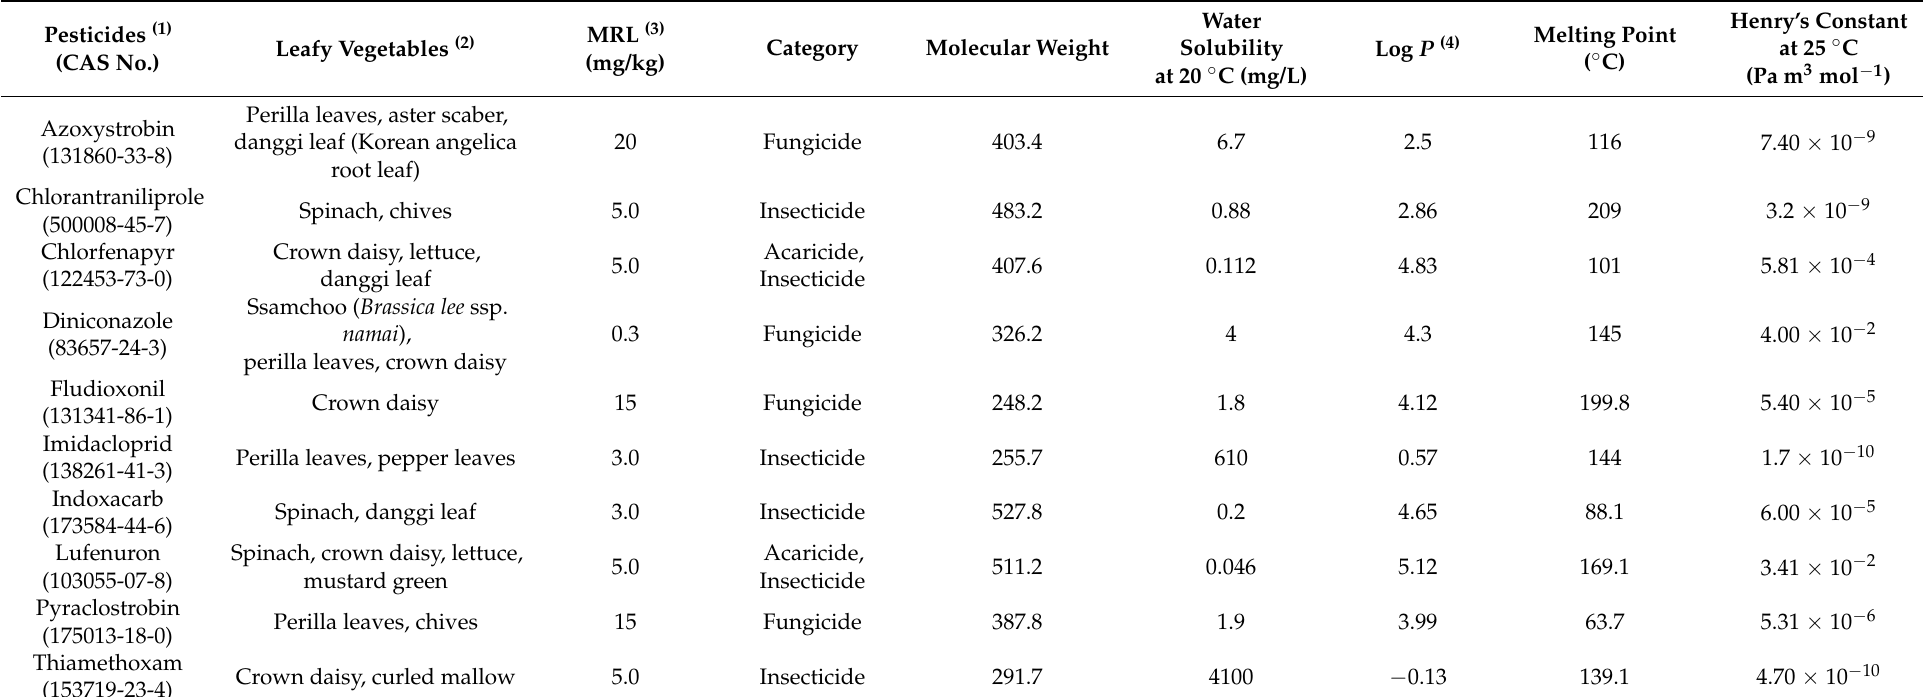
Table 1. The main properties of ten